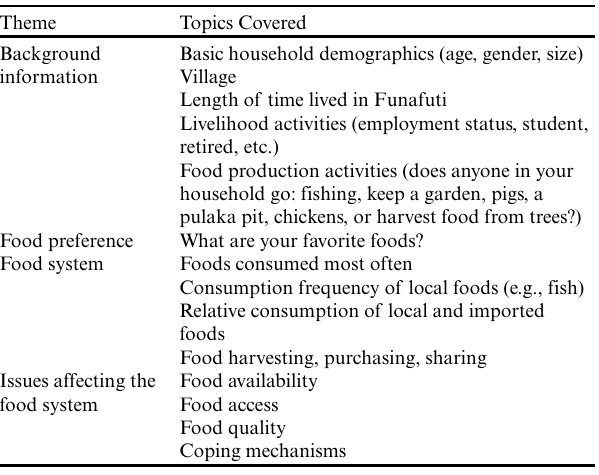
Table 1. Themes and topics covered in household